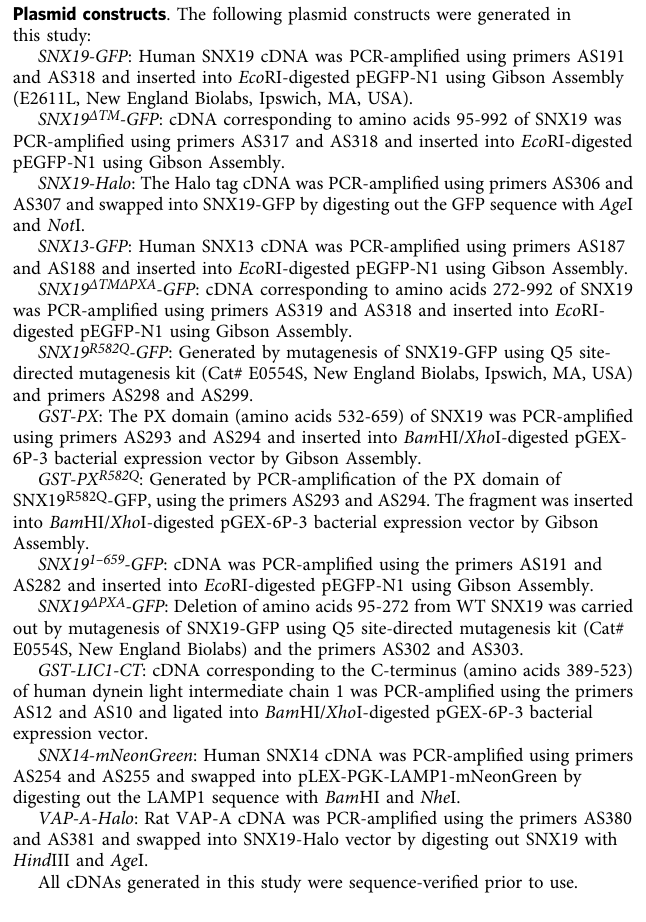
Fig. 6 SNX19 restricts endolysosome motility. a U-2 OS cells were co-transfected with plasmids encoding LAMP1-RFP and GFP-tubulin, imaged live in the red channel at 10 fps for 1 min, and LAMP1-RFP micrographs were subjected to MSS analysis to identify ELs, build EL tracks and classify their motion types: con fi ned, blue; free, green; directed, red; unclassi fi ed, magenta. b Quanti fi cation of LAMP1-RFP tracks generated by MSS from cells treated and imaged as in a , plotted according to the 3 main motion types. Data from 3 independent experiments, each consisting of 7 – 9 cells, are represented as violin plots with lower and upper quartiles in colored dashed lines and the median as a black dashed line. c Overlay of con fi ned (blue) and directed (red) LAMP1-RFP tracks with GFP-tubulin from cell in a . d WT and SNX19-KO U-2 OS cells were transfected with a plasmid encoding LAMP1-RFP, imaged live for 20 s at 10 fps, subjected to MSS analysis, and EL trajectories were plotted as the proportion of ELs with combined free and directed motion (left), or con fi ned motion (right). Data from 3 independent experiments, consisting of 8 – 15 cells per condition per experiment, are represented as violin plots with a thick dashed line representing the median and thin dashed lines representing the quartiles. Mann – Whitney test was applied to determine signi fi cance; *** two-tailed p -value < 0.001. e U-2 OS cells were co-transfected with plasmids encoding GFP or SNX19 1 – 659 -GFP plus LAMP1-RFP, imaged live as described in d , and EL tracks were generated by MSS. f U-2 OS cells were co-transfected with plasmids encoding GFP, WT SNX19-GFP, SNX19 Δ PXA -GFP, or SNX19 1 – 659 -GFP plus LAMP1-RFP, and EL tracks were plotted as the proportion of ELs with combined free plus directed motion (left) or con fi ned motion (right). Data from 3 independent experiments, consisting of 8 – 15 cells per condition in each experiment, are represented as violin plots with a thick dashed line representing the median and thin dashed lines representing the quartiles. Statistical signi fi cance was analyzed by one-way ANOVA; *** p < 0.001. g EL tracks generated by MSS from the SNX19-GFP condition in f . Arrows point to ELs that had visible SNX19-GFP accumulated on them. h Twelve randomly selected videos across 3 independent experiments from the SNX19-GFP condition in f were analyzed for the absence ( − ) or presence ( + ) of visible SNX19-GFP accumulation on ELs as in g , and those EL tracks were represented as box and whiskers plots of the ratio of combined free plus directed motion to con fi ned motion. The box extends from 25th to 75th percentiles, the horizontal line represents the median, and the whiskers represent the minimum and maximum values. Mann – Whitney test was applied to determine signi fi cance; *** two-tailed p -value < 0.001. i Live-cell imaging of the same U-2 OS cell co-transfected with plasmids encoding SNX19-GFP and LAMP1-RFP before (left) and after (right) acute (30 min) treatment with 1 μ M apilimod. Yellow arrowheads point to SNX19-GFP – LAMP1-RFP contacts. j U-2 OS cells were co-transfected with plasmids encoding GFP plus LAMP1-RFP, incubated or not for 30 min in the presence of 1 μ M apilimod, and imaged live as described in d . The proportion of ELs exhibiting combined free plus directed motion types in control (GFP condition from f ) cells and cells treated with apilimod was plotted. Box and whisker plot of data from 18 cells across 3 experiments where the box extends from 25th to 75th percentiles, the horizontal line represents the median, and the whiskers represent the minimum and maximum values. Statistical signi fi cance was analyzed by the Mann – Whitney test, *** two-tailed p -value < 0.001. Source data are provided as a Source Data fi le. Scale bars: 10 μ m in a , c , i , 5 μ m insets and e and g